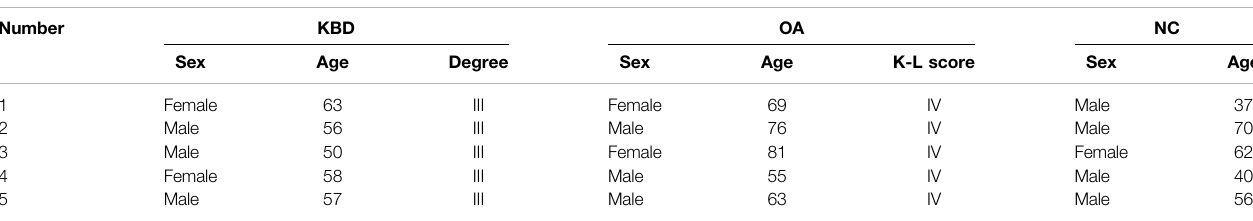
TABLE 2 | General information of subjects for IHC veri fi cation.